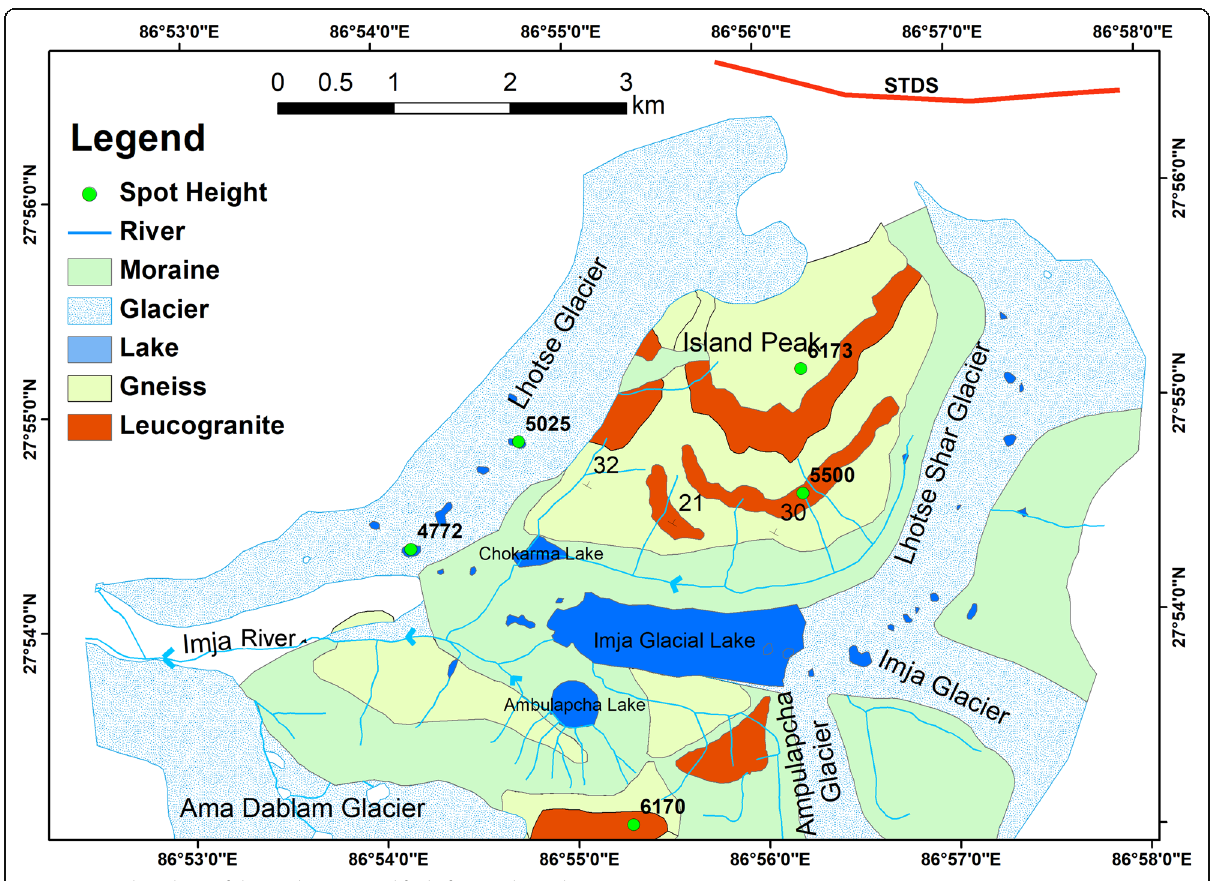
Fig. 2 General geology of the study area (Modified after Searle et al.